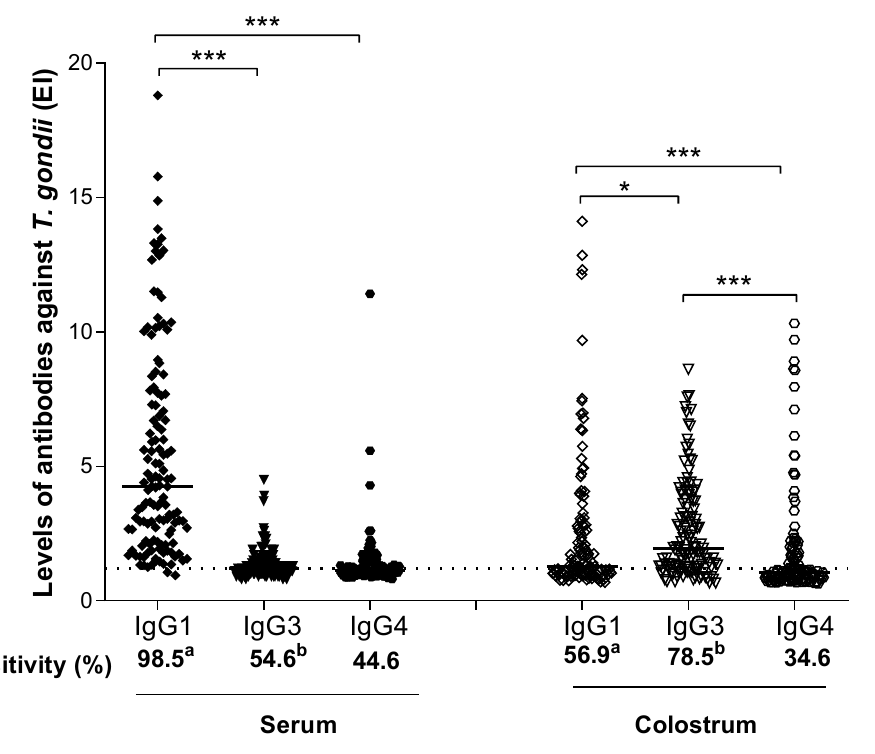
Figure 2. Levels of IgG1, IgG3, and IgG4 antibodies against T. gondii . Data determined by ELISA index (EI), in serum and colostrum samples from 130 puerperal women. The dashed line represents the cut-off value (EI = 1.2). The solid lines represent the values of the medians of the EI for each reaction. Differences between EI levels were calculated by Dunn’s multiple comparison test (* p < 0.05; *** p < 0.001). The differences between the levels of positivity (%) (a and b) of the samples were calculated using the Fisher’s exact test. Equal letters indicate statistical significance ( p < 0.05).